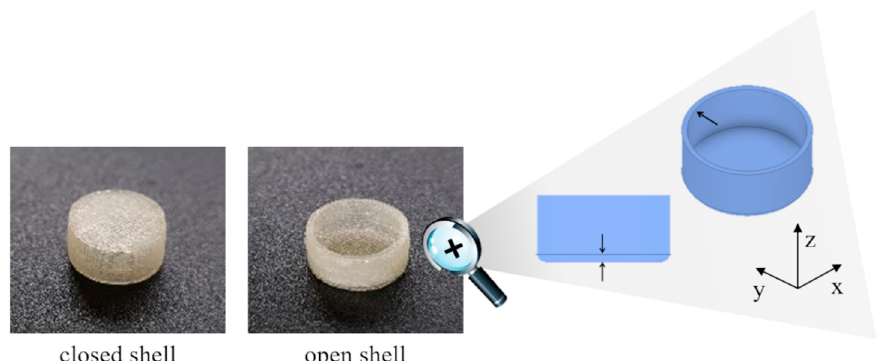
Figure 2. Photographs of empty closed and uncompleted open shells, and outline of the open shell highlighting details relevant to the thickness measurements.